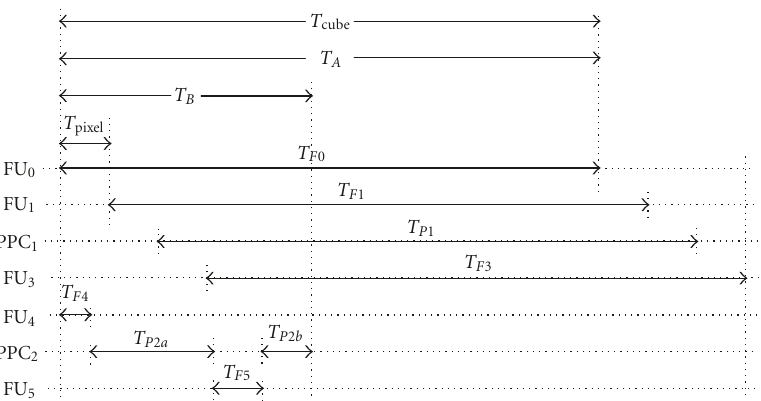
Figure 17: Illustration of timing flow in the single-processing execution